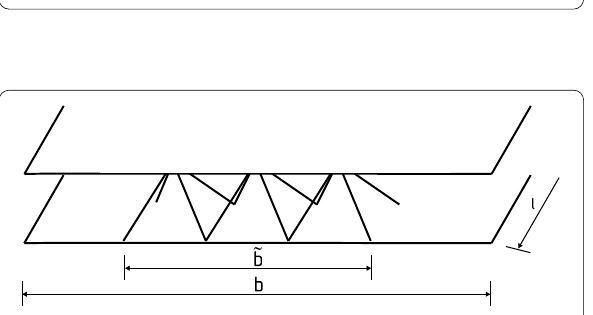
Figure 7 Schematic sketch of the peel test specimens